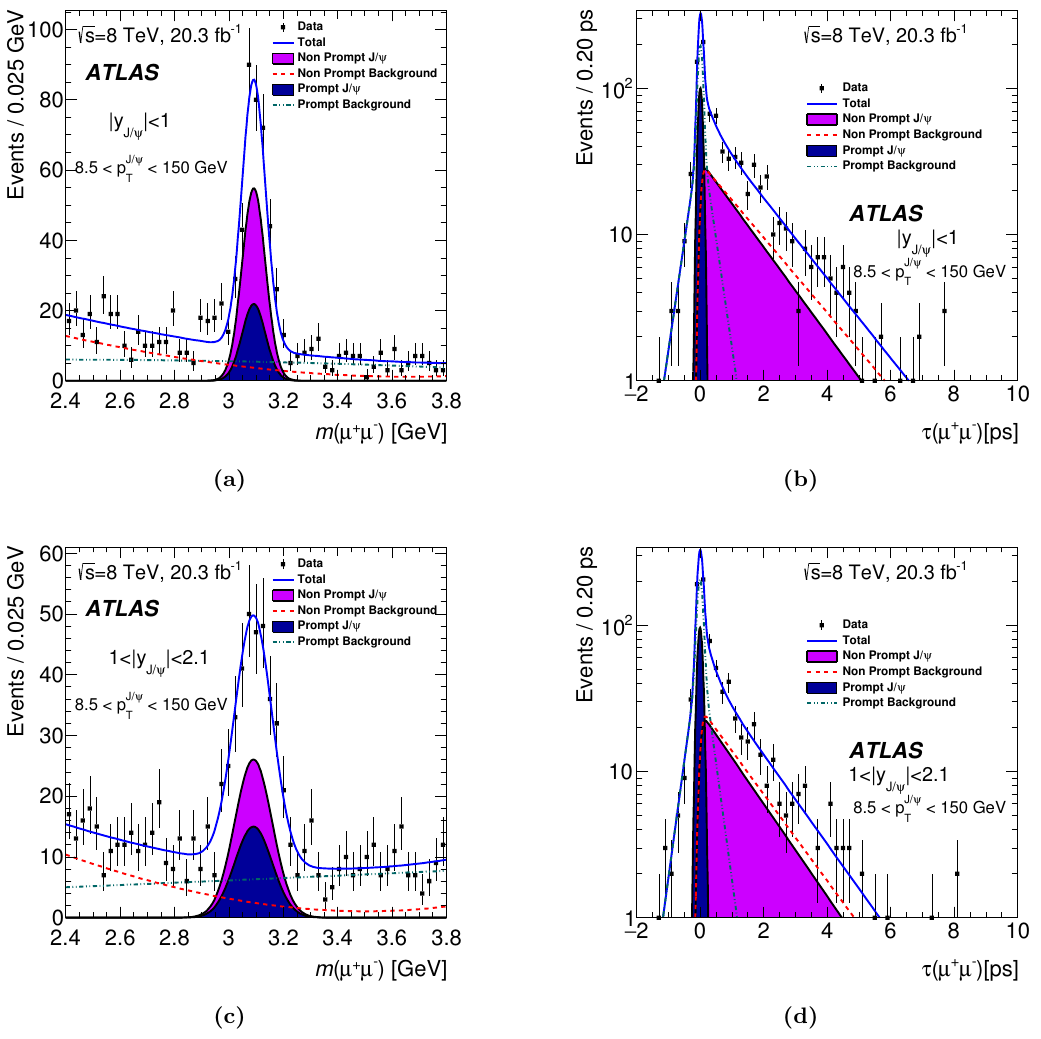
Figure 1. (a) J= candidate mass and (b) pseudo proper decay time for the rapidity range j y j < 1 and p T range 8 : 5 < p J= J= decay time for the rapidity range 1 < j y